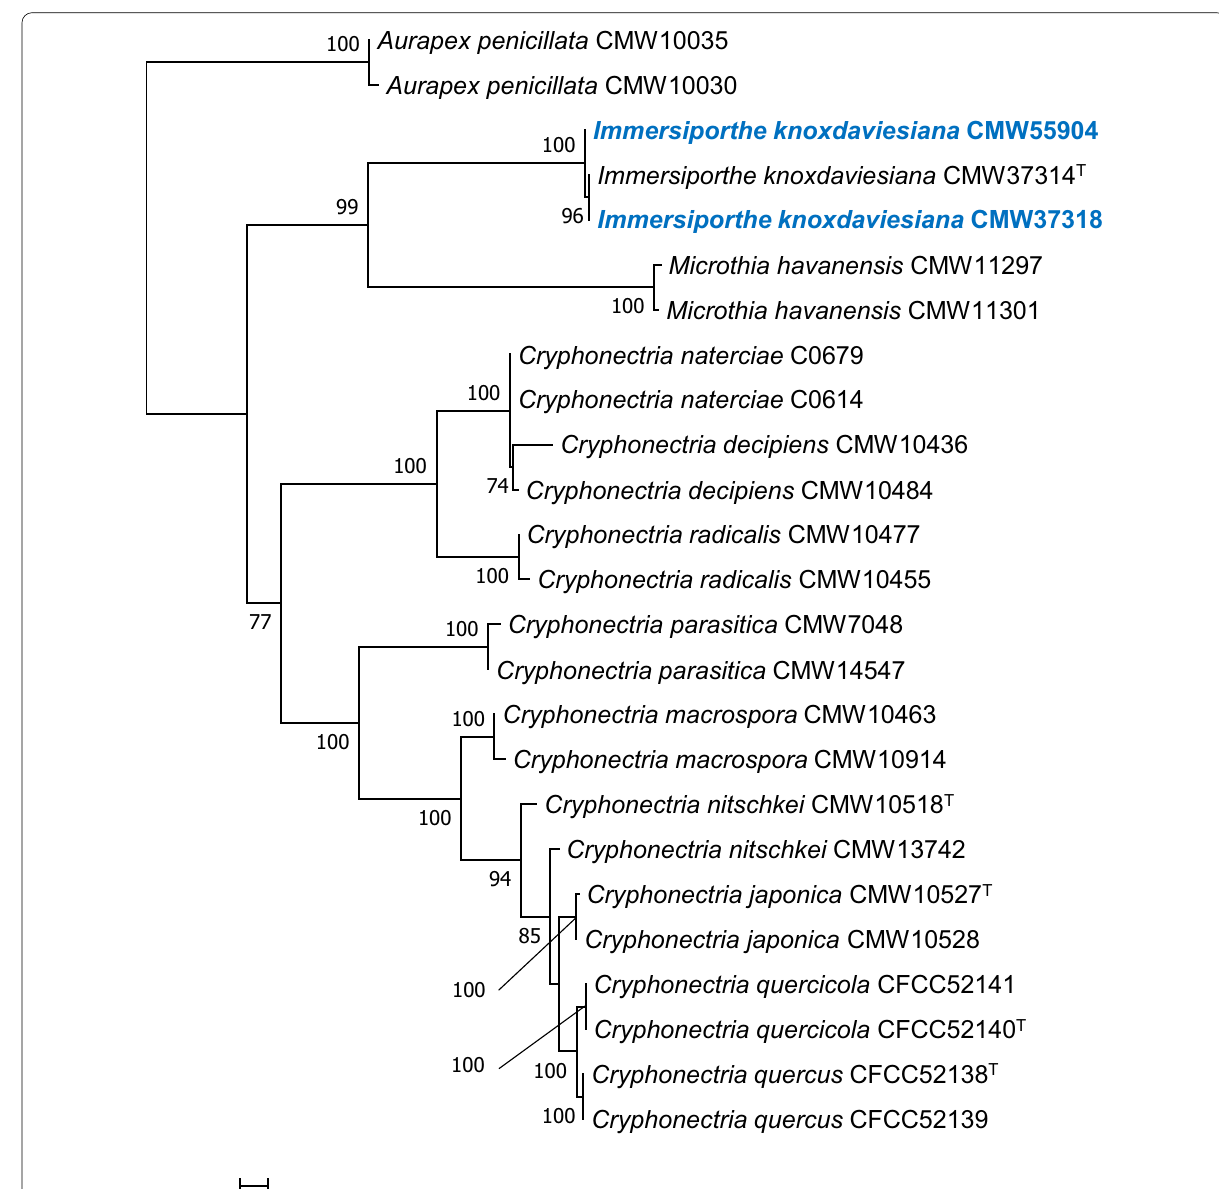
Fig. 3 Maximum Likelihood tree based on ITS region and partial gene sequences of but1 and but2 . Bootstrap values > 70% are shown. The isolates used in this study are indicated in blue and bold. T indicates ex-type